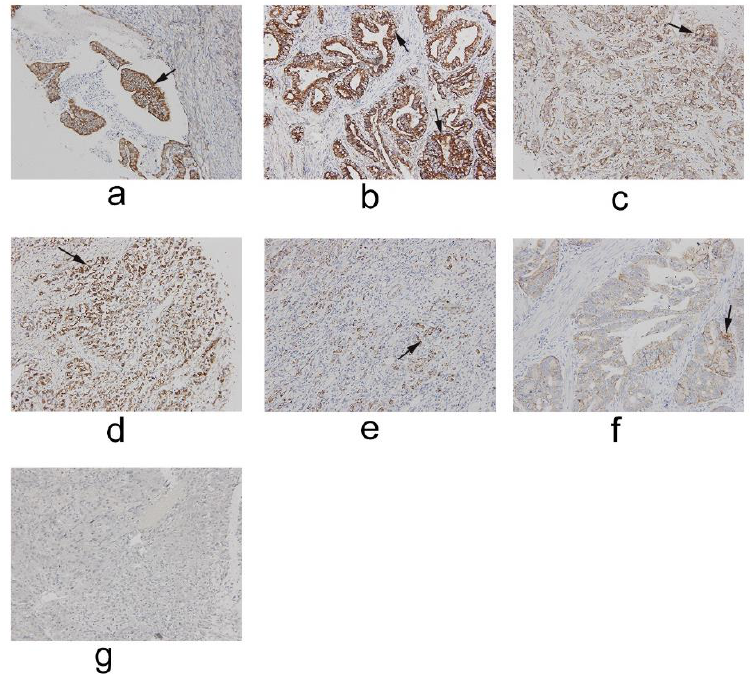
Figure 1. Immunohistochemical analysis of IFT80 in different types of gastric cancer. Expression of IFT80 was determined by immunohistochemical staining with an IFT80 antibody. ( a ) Gastric cancer tissue (type: malignant; pathology: adenocarcinoma; stage: II; TNM stage: T3N0M0; grade: 1) (200×).